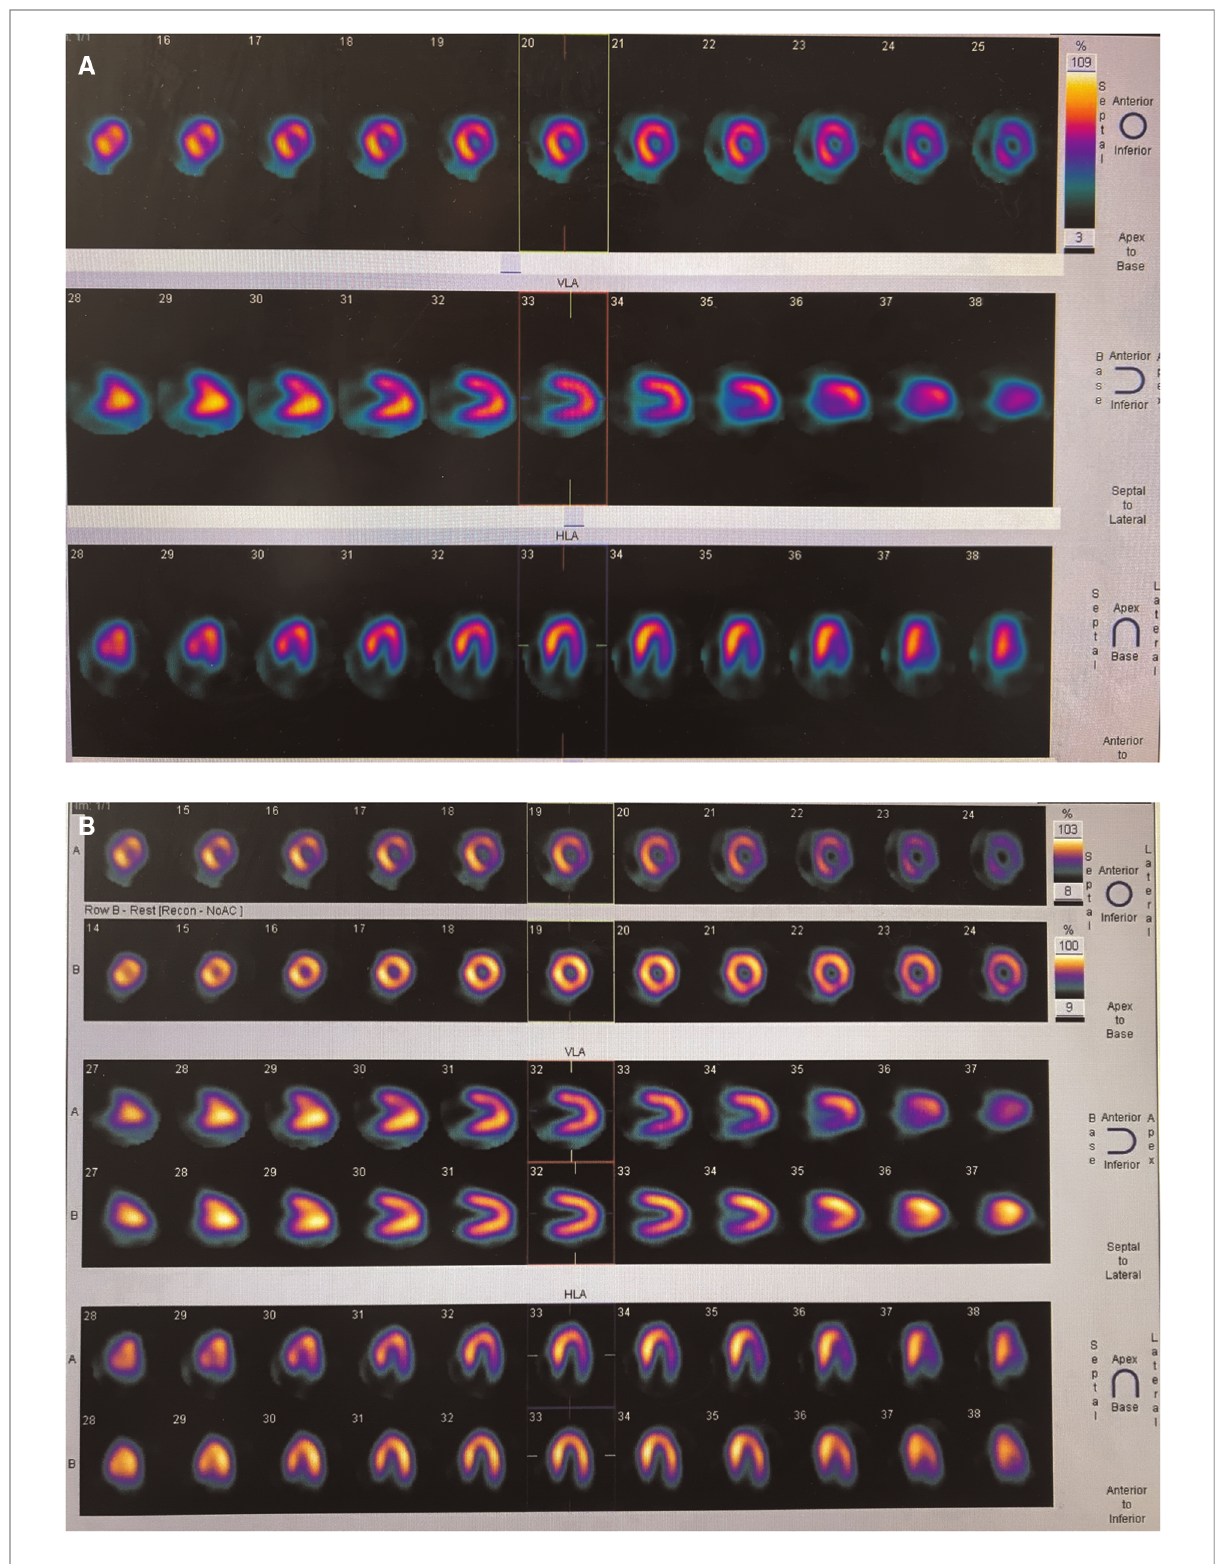
FIGURE 1 ( A ) ATP stressed myocardial perfusion imaging (MPI) demonstrated ischemia in the anterior wall near the apex, inferior wall, posterior wall, and lateral wall of the left ventricle. ( B ) Routine MPI showed uniform myocardial